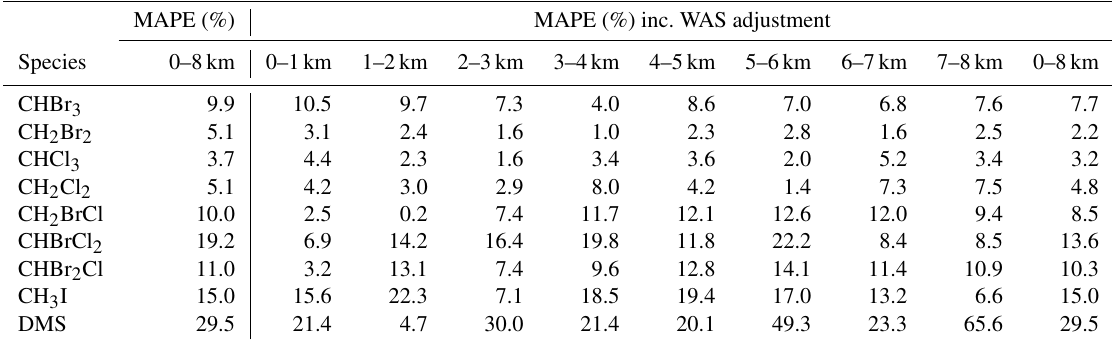
Table 2. Summary of calculated mean absolute percentage error (MAPE) between the four instruments (two instruments in the case of CH 2 BrCl and DMS). Second column shows MAPE without the offset correction to WAS data applied. MAPE is shown for each altitude bin, and the average MAPE for the entire 0–8km profile. MAPE (%) MAPE (%) inc. WAS